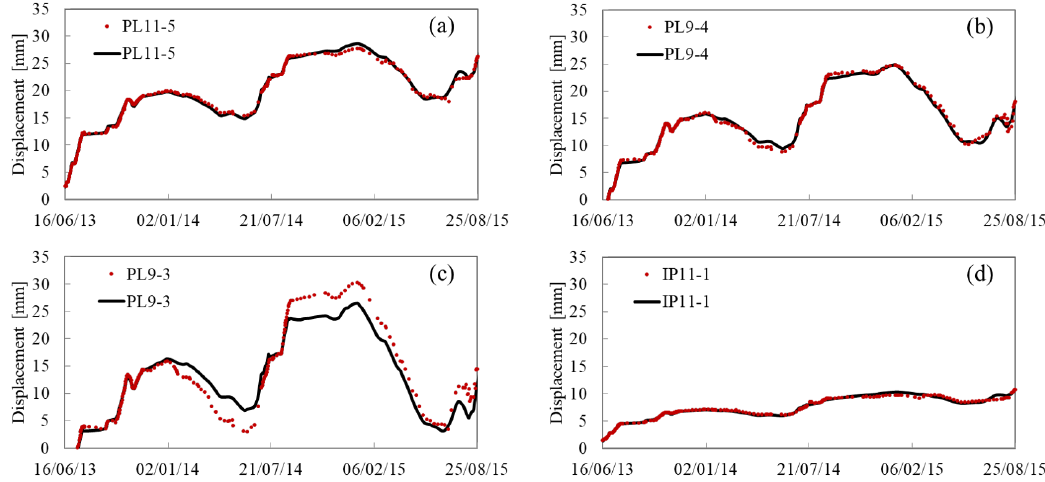
Figure A2. The fitting and forecast results of Class 3: ( a ) IP 16-3; ( b ) IP 16-2; ( c ) PL 13-4; ( d ) PL 13-3; ( e ) PL 11-4; ( f ) PL 11-3.